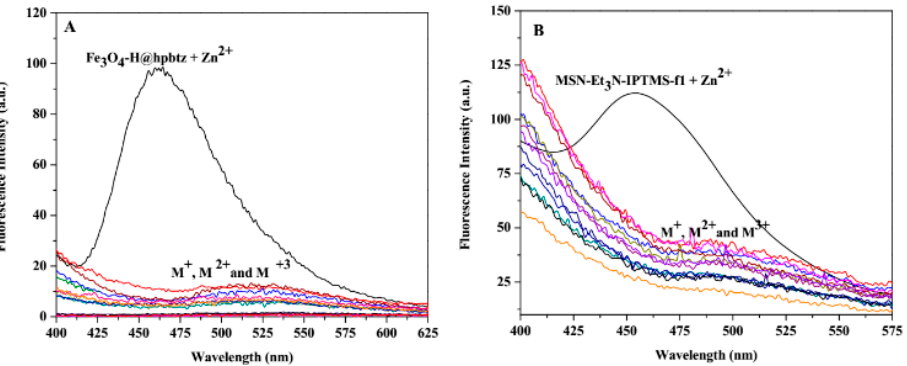
Figure 13. Fluorescence emission spectra for ( A ) Fe 3 O 4 -H@hpbtz in the presence of 7.8 equivalent, 300 µ L and ( B ) MSN-Et 3 N-IPTMS-hpbtz- f1 in the presence of 15.4 equivalent, 350 µ L of various metal ions at λ = 350 and 305 nm, respectively, in ethanol.